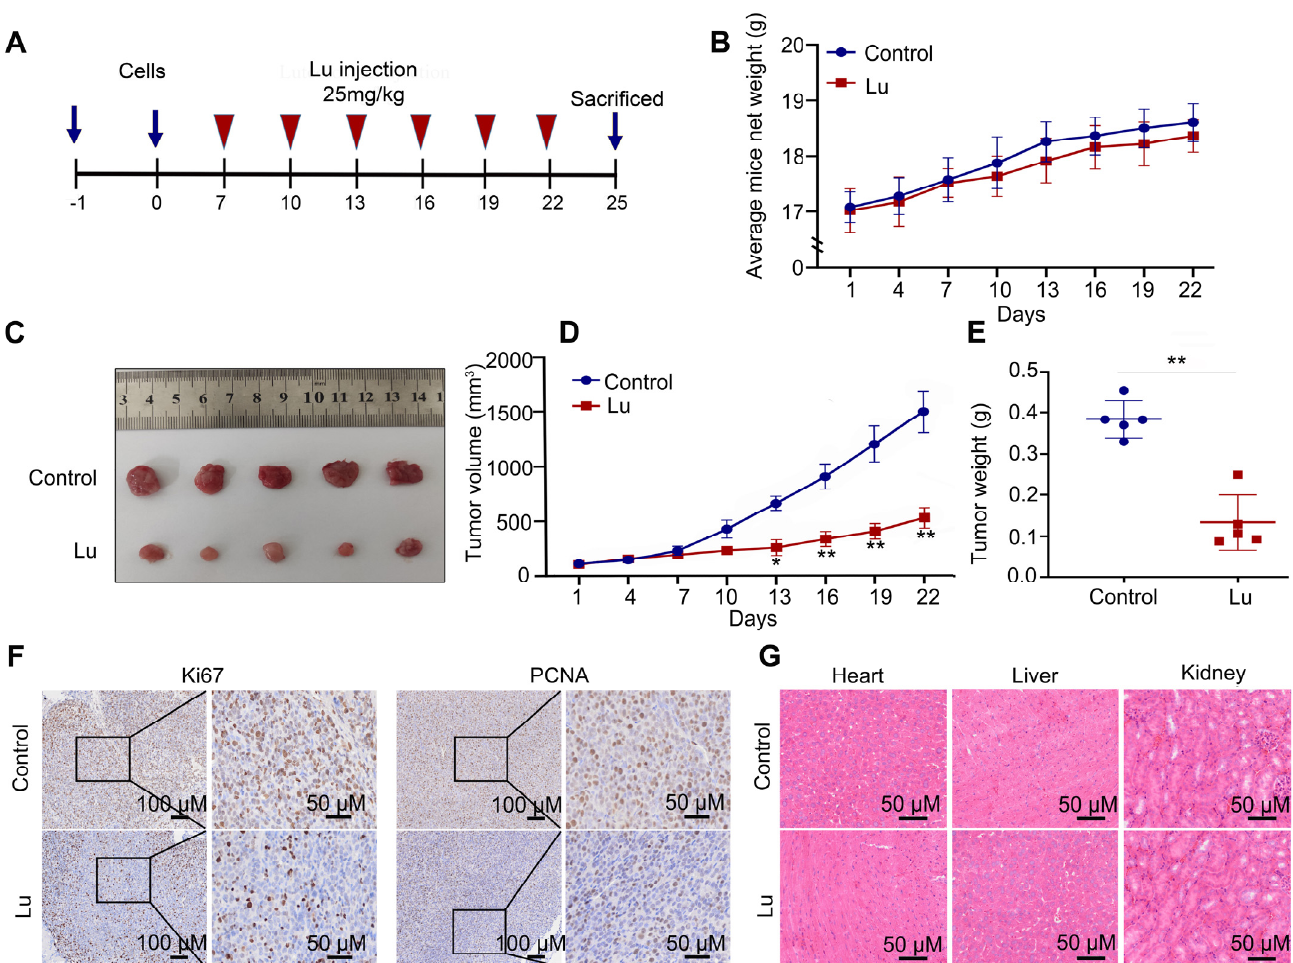
Figure 4. Luteoloside suppressed tumor growth in vivo. ( A ) The process sketch diagram. ( B ) The average mouse weight treated with DMSO or luteoloside. ( C – E ) Tumor volume and weight of tissues treated with DMSO or luteoloside. ( F ) The expression of Ki67 and PCNA in neuroblastoma and adjacent tissues was analyzed using immunohistochemical staining (IHC). ( G ) Hematoxylin–eosin (HE) was used to evaluate toxicity to the heart, liver, and kidney after treatment with luteoloside. *, p < 0.05; **, p < 0.01. n = 5. The control group is used for comparison. Data are shown as mean ± SD.